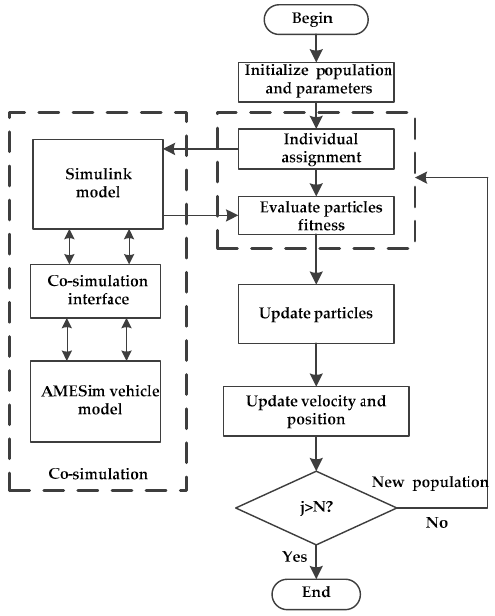
Figure 14. The optimization process of PSO based on co-simulation platform.